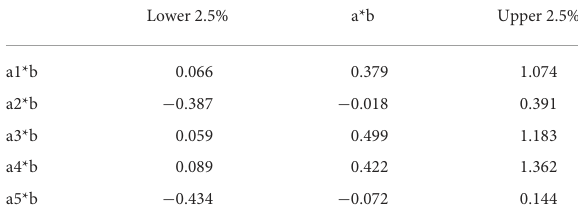
TABLE 5 Indirect effects (Bias-corrected